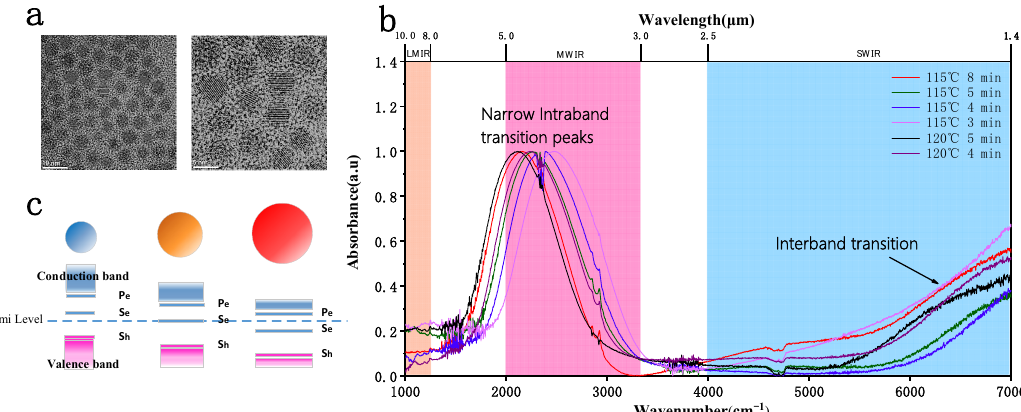
Figure 1. Characterization of HgSe CQDs materials. ( a ) TEM images of HgSe CQDs with a particle diameter of 4.7 nm and standard deviation of 0.5 nm. ( b ) Absorption spectra of HgSe CQDs. ( c ) Diagram of the relationship between the size of CQDs and energy bands.